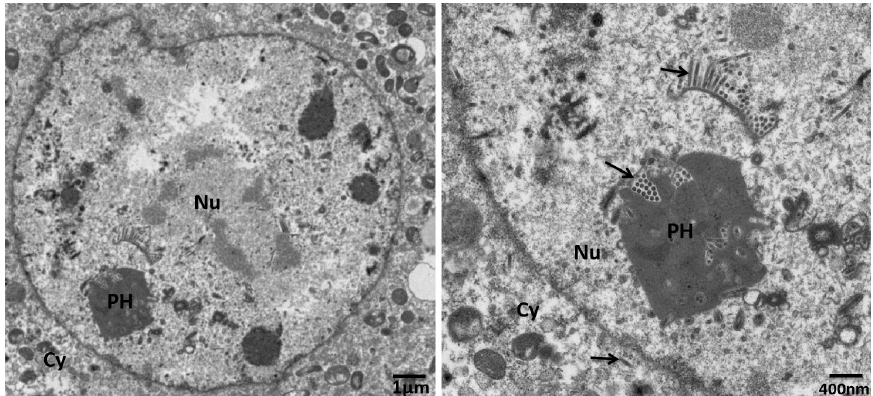
Figure 5. Electron microscope analysis of BmNPV infected BmN cells after p26 knockdown. At 72 h post-dsRNA treatment, the cells were harvested for transmission electron microscope analysis. Cy, Nu, and PH denote cytoplasm, nucleus, and polyhedra, respectively. The black arrow refers to nucleocapsids and